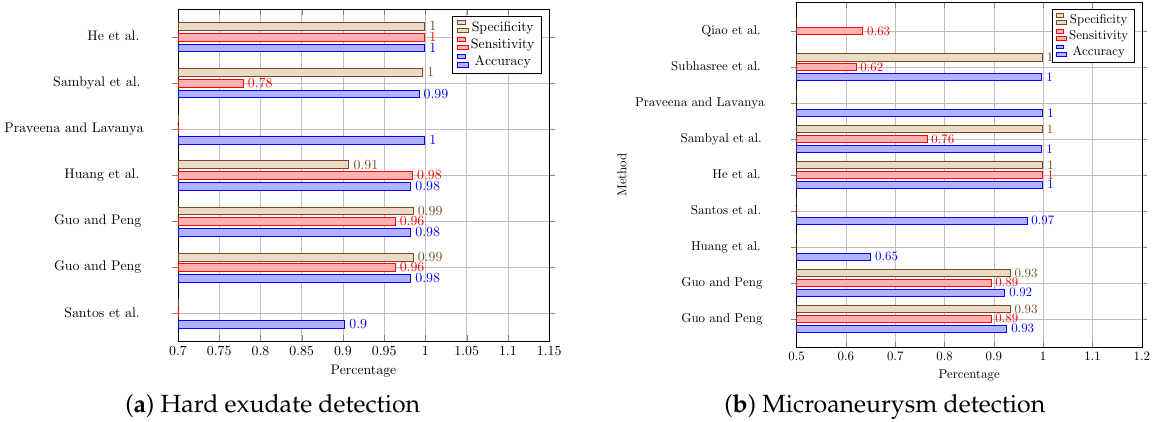
Figure 6. Performance comparison of deep-learning based diabetic retinopathy with hard exudate and microaneurysm detection studies which employed the IDRiD dataset